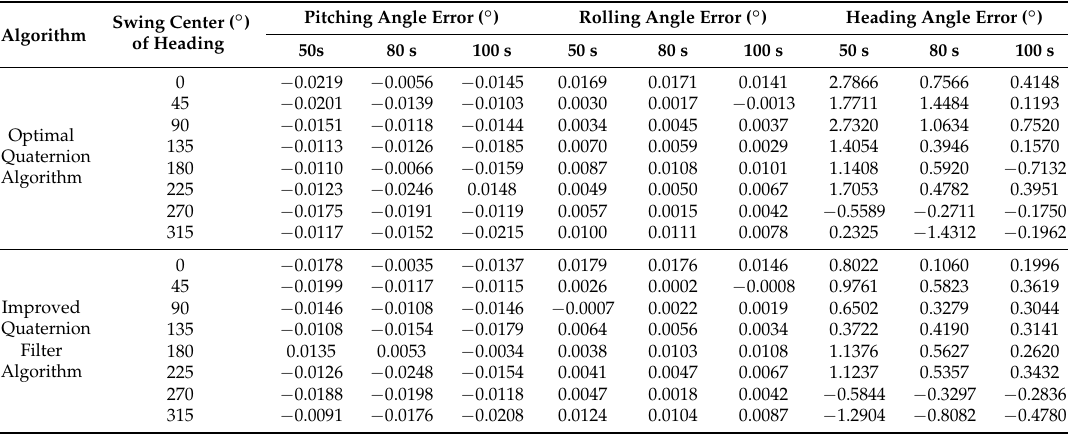
Table 2. Errors of two coarse alignment